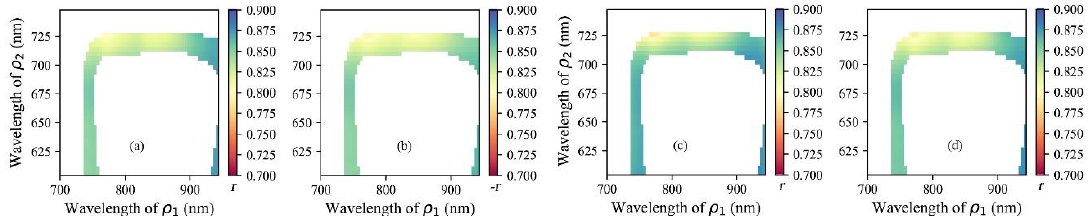
Figure 7. Autocorrelation analyses between any ρ 1 and ρ 2 bands (600–950 nm). ( a ) the r values; ( b ) the p values (> 0.05).